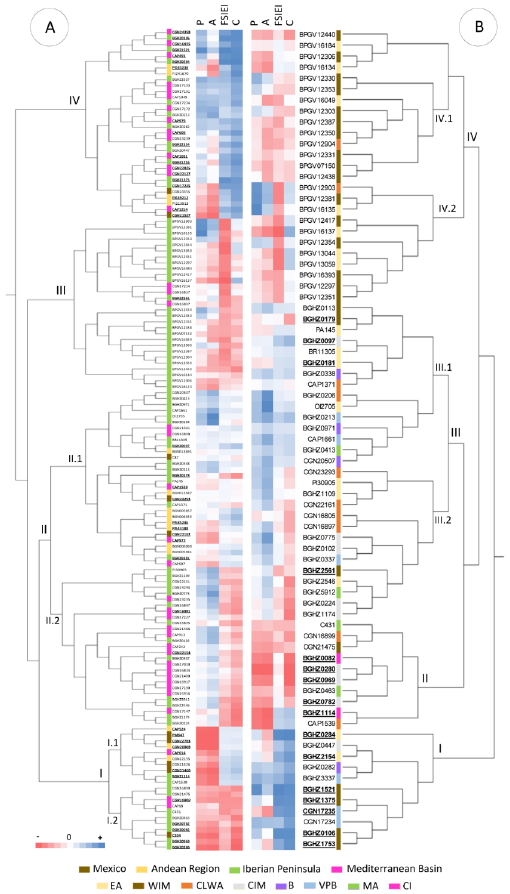
Figure 7. Cluster analysis for global ( A ) and Iberian ( B ) accessions. The heatmap represents the variables standardized to z-scores. EA = European Atlantic, BP = Betica Province, CIM = Central Iberian Mediterranean, CLWA = Coastal Lusitania and West Andalusia, MA = Murcia and Almeria, VPB = Valencia-Provence and Balearic, WIM = West Iberian Mediterranean, and CI = Canary Islands. Pungent accessions are in bold and